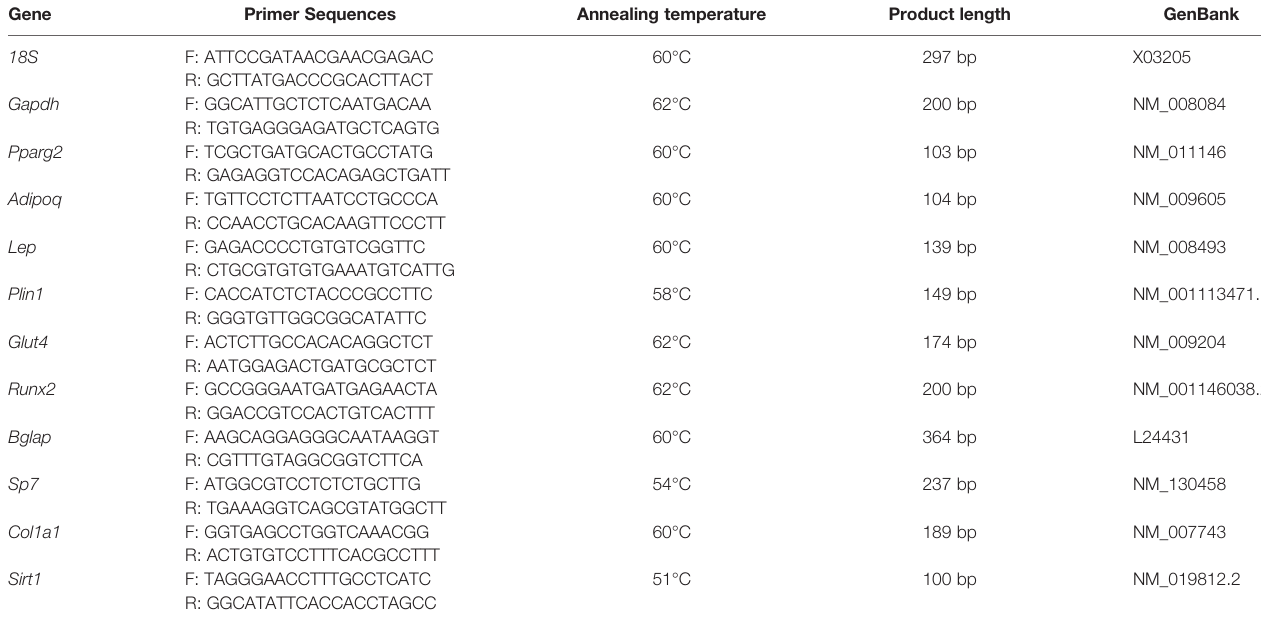
TABLE 2 | Primer sequences and conditions of quantitative RT –